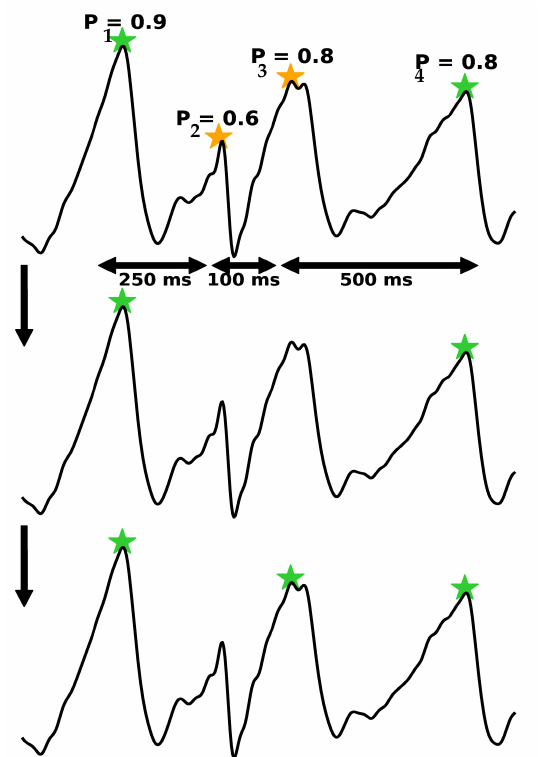
Figure 11. Filtering the unnaturally close peaks in the peak correction step. The upper figure shows all of the detected peaks. The middle plot illustrates the removal of the peaks that are within the threshold distance. The lowermost figure shows that the peak with the highest probability is added back into the final set of accepted